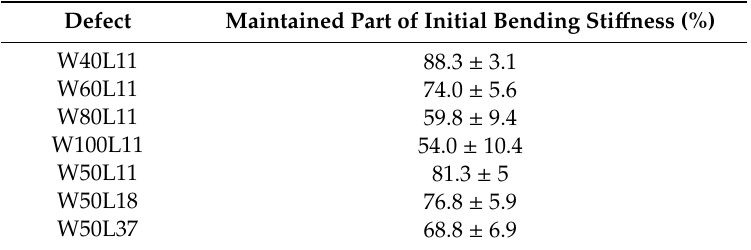
Table 4. The reduced bone bending sti ff ness due to the cortical window geometries.